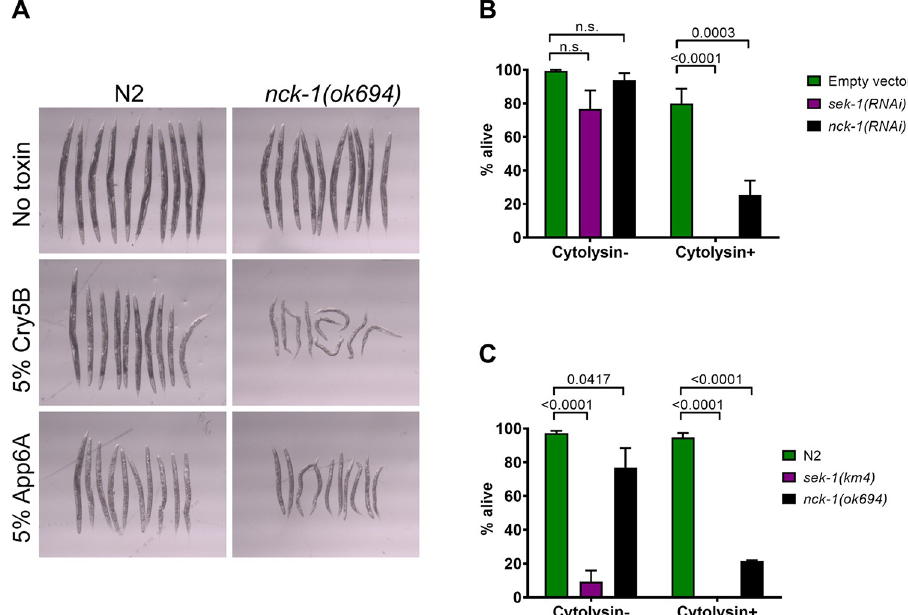
Fig 4. nck-1 loss sensitizes C . elegans to multiple PFPs. (A) Wild-type N2 or nck-1(ok694) null C . elegans L4s were transferred to plates spread with the indicated percentage of E . coli expressing Cry5B or App6A (formerly Cry6A). Plates were incubated two days at 20˚C and then worms were transferred to spot wells and photographed. (B) Wild- type N2 C . elegans grown to the L4 stage on the indicated RNAi bacteria were transferred to plates spread with Vibrio cholerae that do or do not express the PFP cytolysin, and survival was measured after 48 hours. (C) The same experiment as in (B) but using wild-type N2 or mutant C . elegans L4 animals. The data in (A) are representative of three independent trials. For (B) and (C), each data point is the average of three independent experiments with one plate/experiment (n = 50